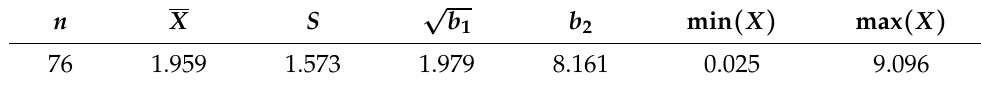
Table 2. Descriptive statistics for kevlar dataset.